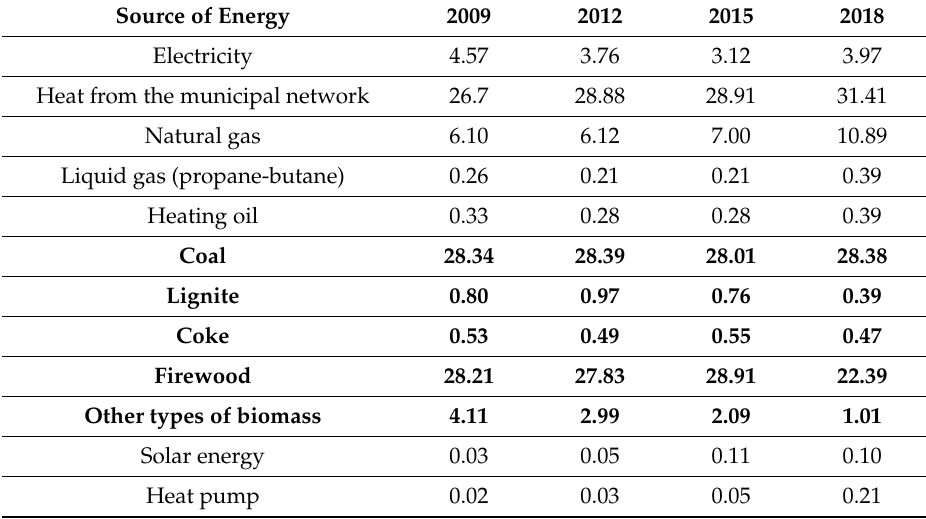
Table 1. Share of households using individual energy carriers for space heating in Poland